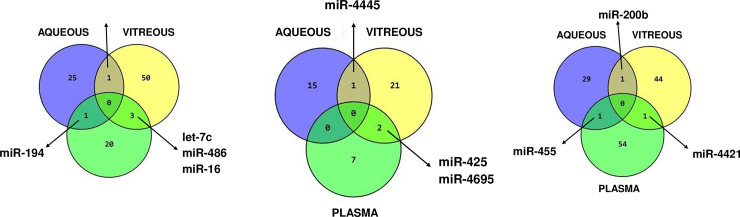
The comparative analyses of miRNA dysregulation in aqueous, vitreous, and plasma for each DR sub-category.A. DMI-PDR; B. DMII-PDR; C. DMII-NPDR.